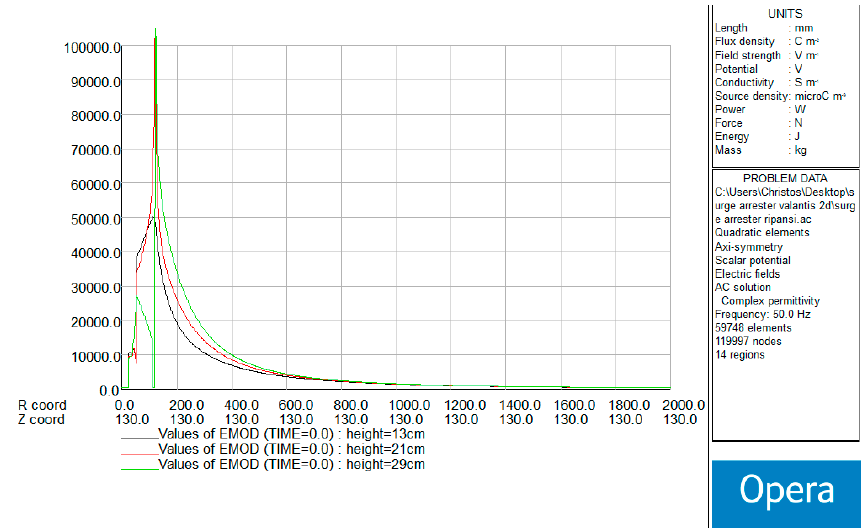
Figure 10. Electric field distribution around the arrester under study in the case of pollution on the surface of the external insulation (2D PC Opera).